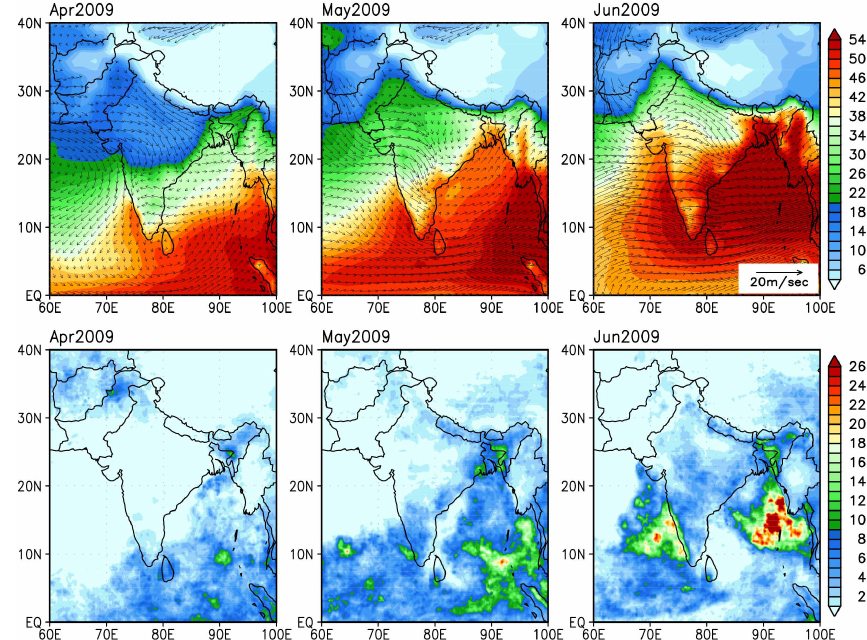
Fig. 4. Monthly mean column water vapor (top panel, unit: mm) obtained from MERRA data monthly mean rainfall rate (bottom panel, unit: mmday − 1 ) from TRMM data for April, May and June 2009. Southwest Asian regions remain largely dry during the entire pre-monsoon period while the Western Ghats, Bay of Bengal and Northeastern India show characteristic increase in both the moisture influx and rainfall, most pronounced during the monsoon onset in June 2009.